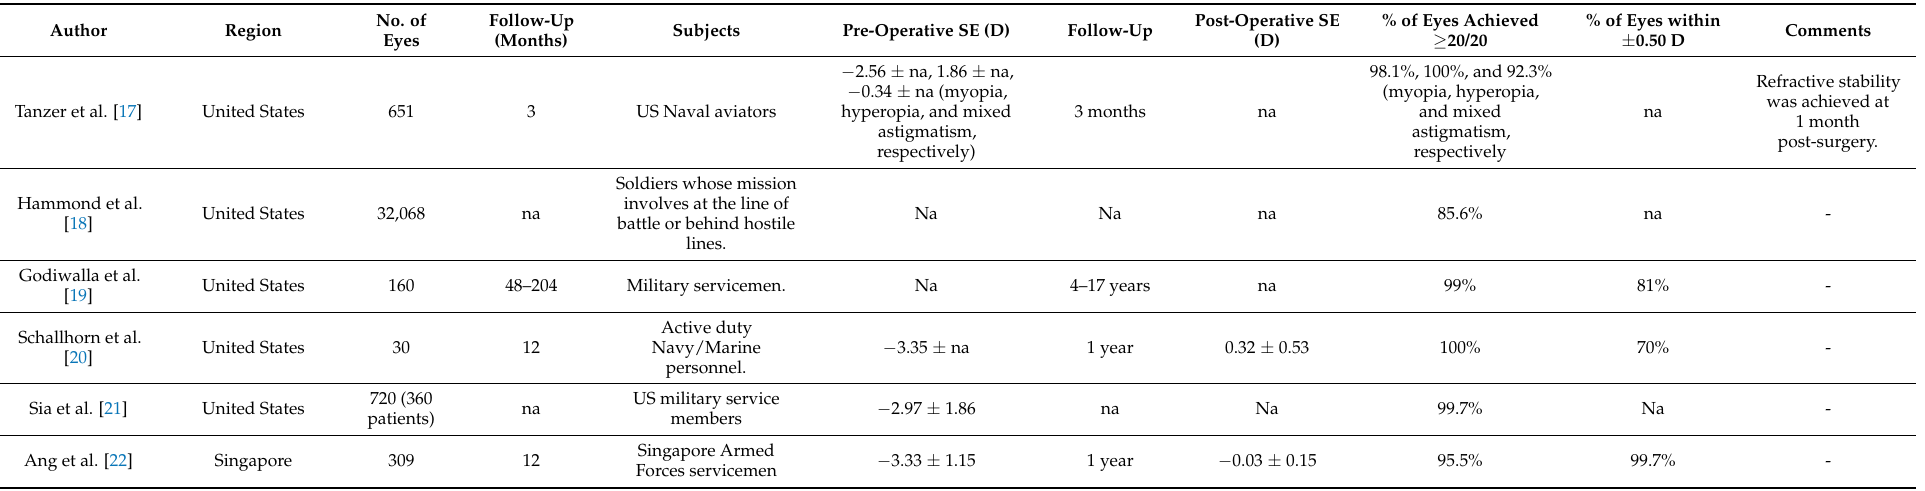
Table 1. Previous studies conducted on post-refractive surgery military personnel.